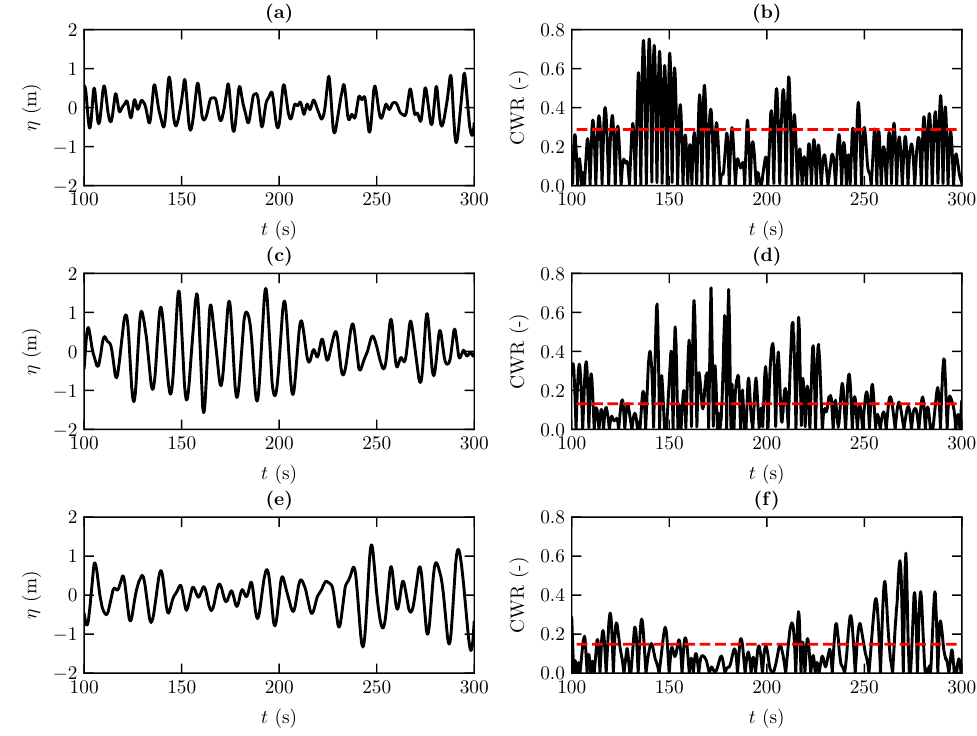
Figure 14. Detail of surface elevation and CWR for ( a , b ) H s = 2 m and T = 7 s, ( c , d ) H s = 2 m and T = 9 s, ( e , f ) H s = 2 m and T = 11 s. In the power capture curve, the horizontal dashed red line indicates the mean power